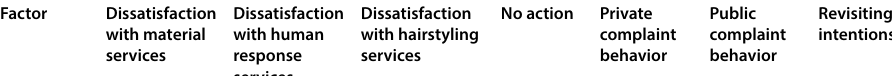
Table 3 Average variance extracted and squared correlation coefficient of variables